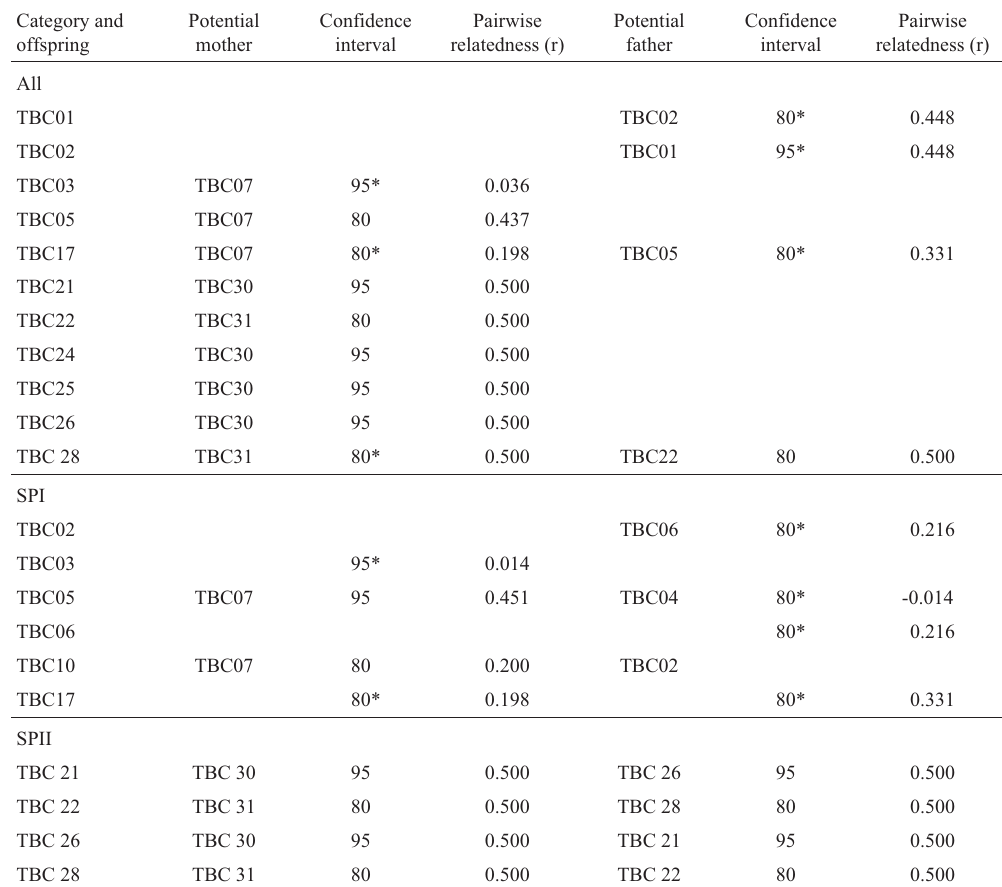
Table 4 - Maternity and paternity parentage assignment analysis, by category, for Myrmecophaga tridactyla sampled at Emas National Park, Brazil. All, includes all categories -SPI, SPII and Periphery. Category and